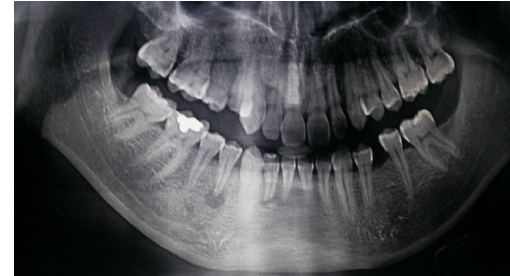
Figure 5: OPG of the same patient illustrating periapical radiolucent lesion at the adjacent